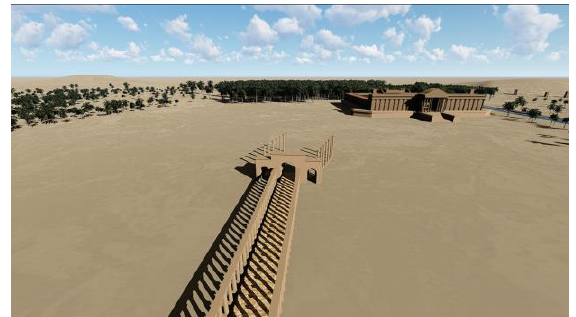
Figure 2. Triumphal arch directs the view to the entrance of the temple